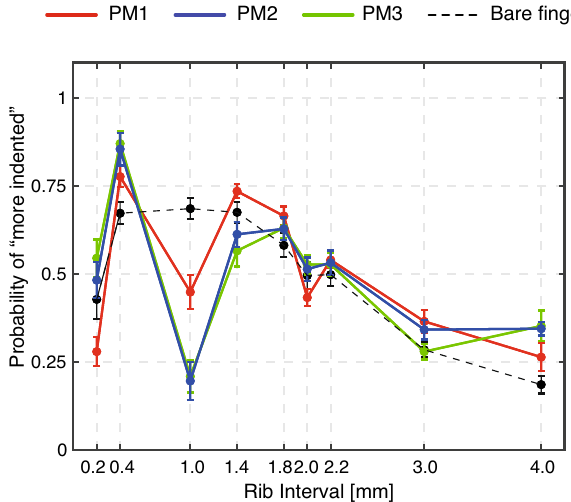
Figure 2. The touch condition affects the mean probability of perceiving a more indented (hollower) surface geometry. Participants examined a pair of different fishbone patterns (36 combinations in total), and they indicated which pattern was more indented in each trial under a certain touch condition (bare finger or utilizing pin matrix (PM) 1, 2, or 3. Psychological data showed different probabilities of answering “more indented” than other rib intervals ( N = 12 ). The horizontal axis represents the rib interval in the fishbone surface pattern. Under bare-finger conditions, the probability increased between 0.2 and 0.4 mm and gradually decreased when the rib interval exceeded 1.4 mm. The probability trace was exaggerated under pin matrix conditions. Specifically, the probability steeply increased between 0.2 and 0.4 mm and decreased as the rib interval increased under touch conditions with PM1, except for the steep dips at rib intervals of 1.0 and 2.0 mm. This trend was more enhanced under touch conditions with PM2 and PM3. In particular, the probability of more indented was abruptly decreased at the 1.0 mm rib interval. Mean estimates of probability are plotted, and error bars indicate 95% confidence